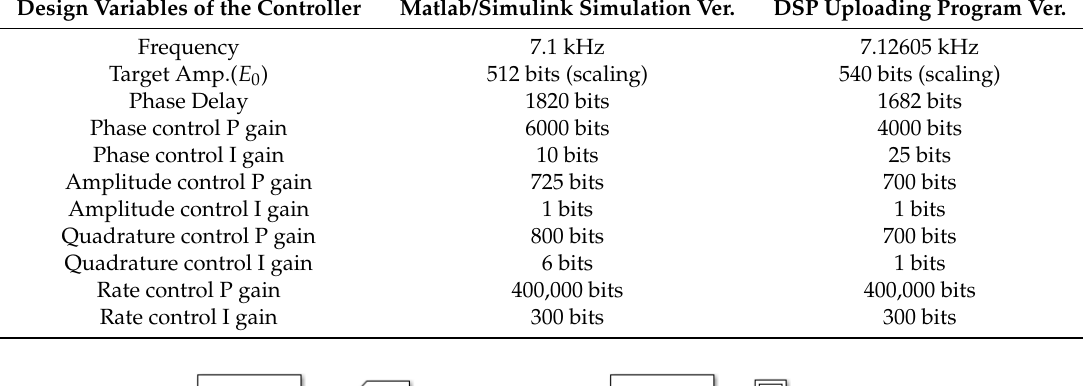
Table 9. Comparison of controller gains for simulation and DSP uploading program. Design Variables of the Controller